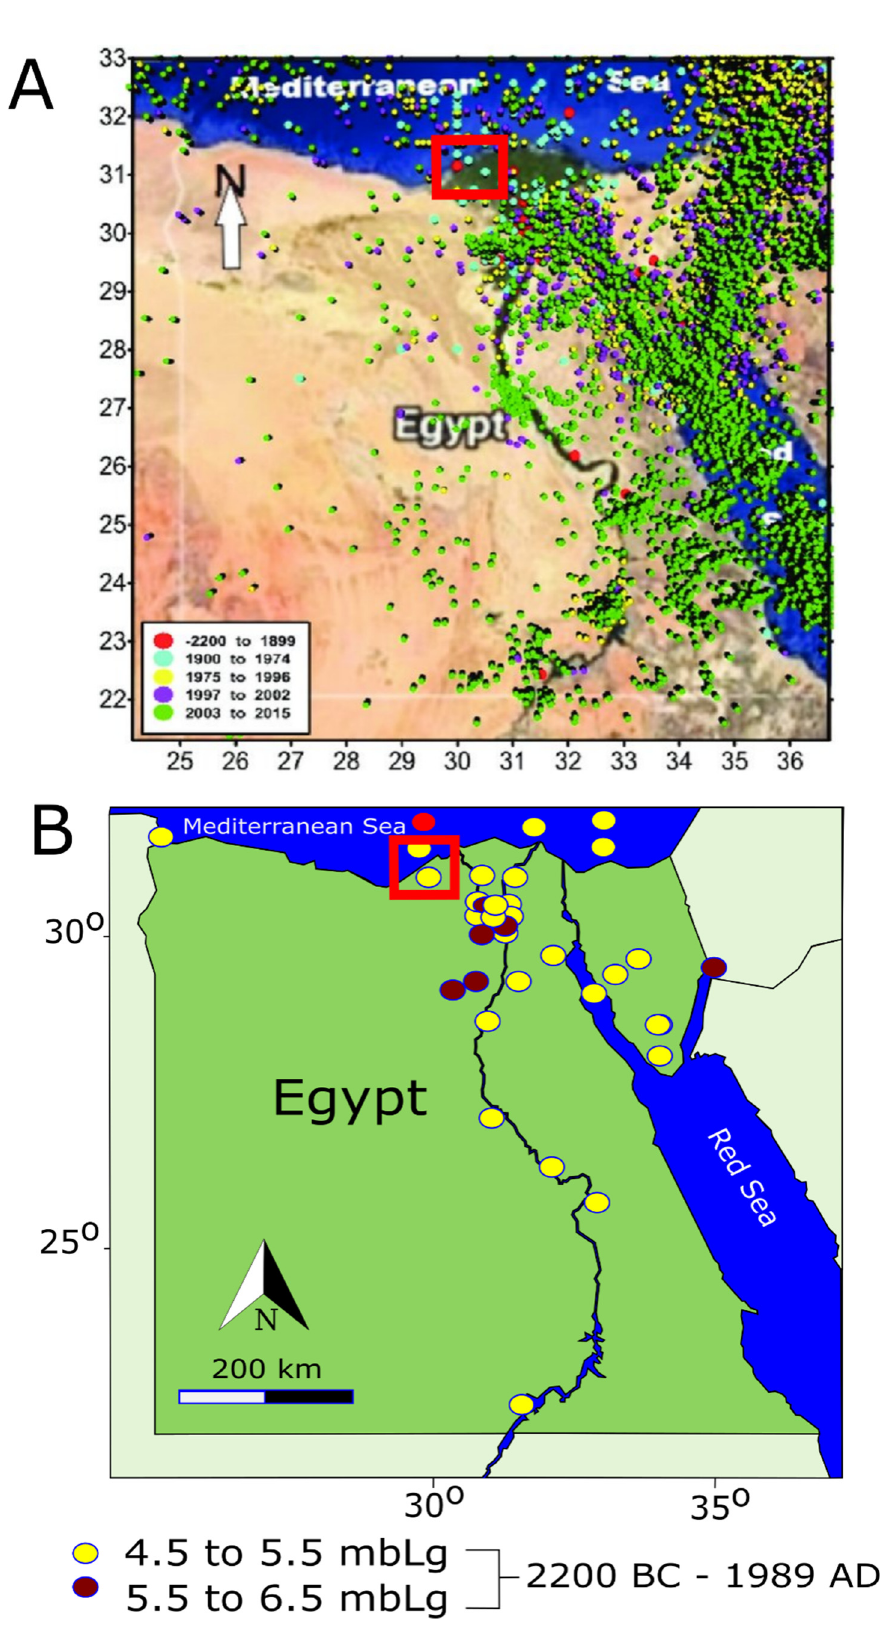
Figure 8. ( A ) General distribution of the historical record of earthquakes in Egypt (2200 BC to 2015 AD). ( B ) Map of historical earthquakes with their magnitudes from 2200 BC to 1989 AD, after [61]. Red squares represent the Alexandria area.